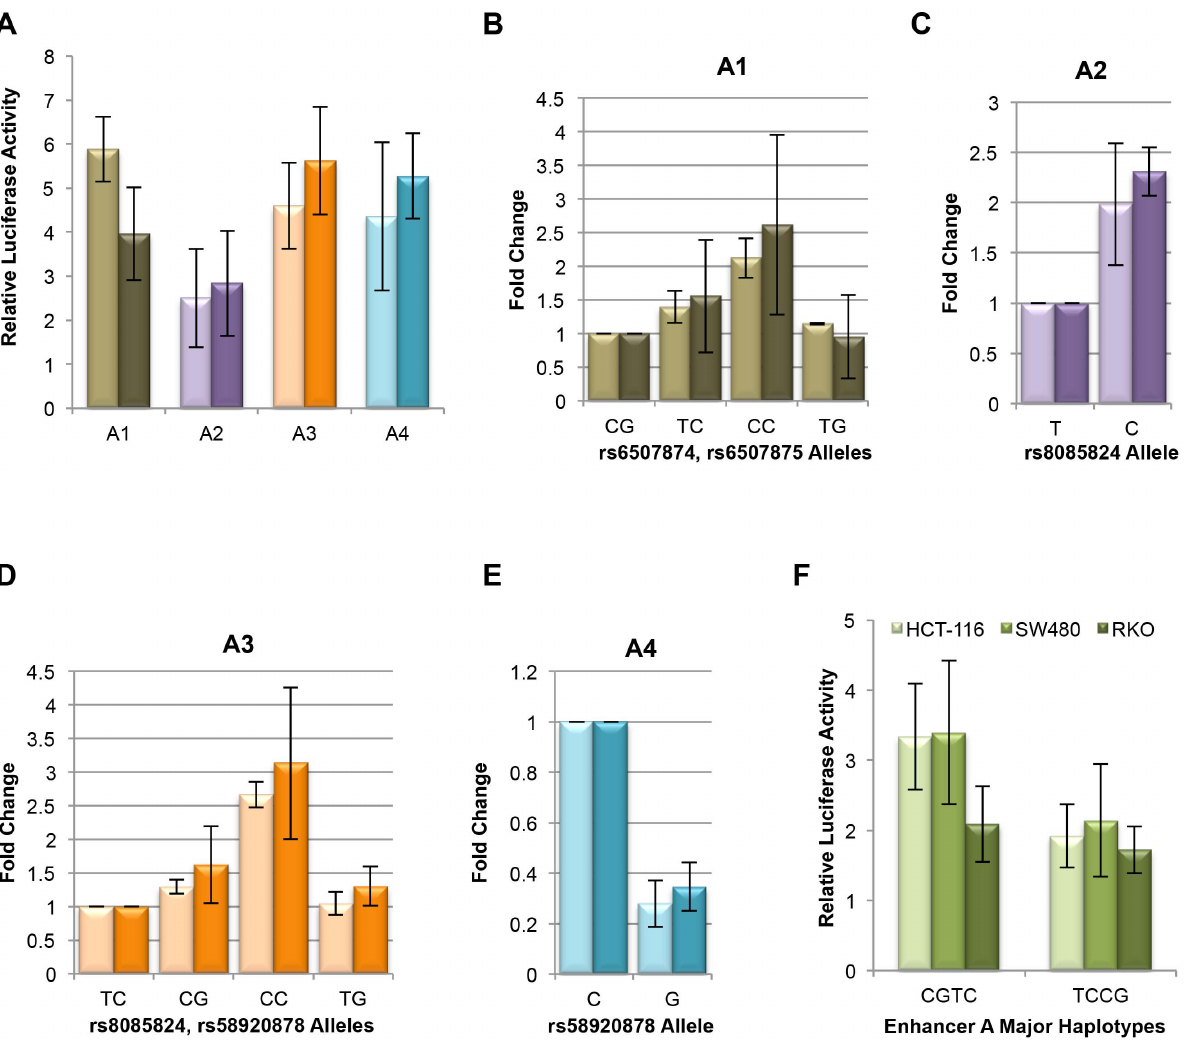
Figure 3. Fragment A is composed of smaller domains with independent enhancer activity. ( A ) Fragment A was divided into 4 smaller DNA fragments, A1–A4, depicted in Figure 1D. Each smaller fragment demonstrated enhancer activity in both HCT-116 (light bars) and SW480 (dark bars). For the experiment shown, all SNPs contained their C alleles. ( B ) Activity of Fragment A1 containing rs6507874 and rs6507875, shown as fold change relative to the major haplotype CG for HCT-116 (light bars) and SW480 (dark bars). The minor haplotype TC ( p =2.25 6 10 2 2 (HCT-116), p =8.59 6 10 2 2 (SW480)), and combination CC ( p =5.06 6 10 2 5 (HCT-116), p =1.75 6 10 2 5 (SW480)) not seen in the CEU population show higher activity than the major haplotype. Combination TG ( p =0.450 (HCT-116), p =0.287 (SW480)) demonstrates activity similar to CG. ( C ) Fragment A2 containing rs8085824 shows 2-fold higher enhancer activity with the minor C allele of than the major allele T ( p= 4.75 6 10 2 3 (HCT-116), p= 3.61 6 10 2 4 (SW480)). ( D ) Activity of fragment A3 containing rs8085824 and rs58920878 relative to major haplotype TC. The minor haplotype CG demonstrates higher activity than TC ( p= 2.49 6 10 2 2 (HCT-116), p= 6.32 6 10 2 3 (SW480)). The T (major) allele of rs8085824 shows lower activity than C (minor) allele regardless of rs58920878 allele. The highest activity is seen in haplotype CC that is not reported in the CEU population ( p= 6.35 6 10 2 7